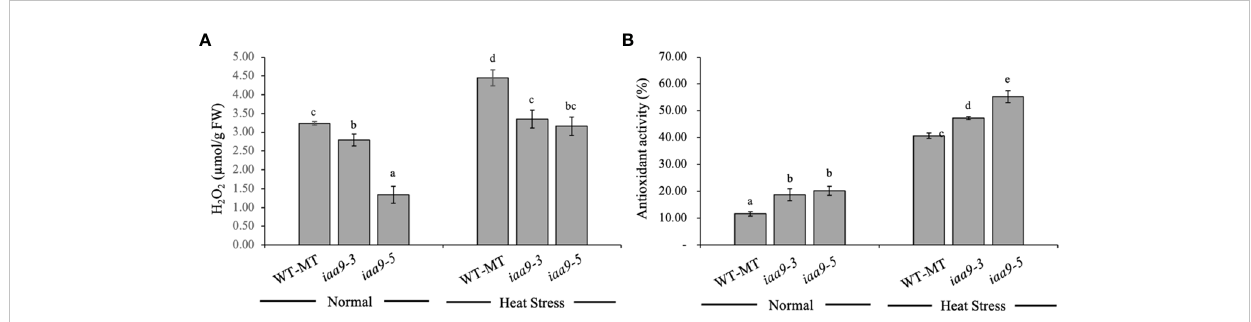
FIGURE 7 (A) H (B) Antioxidant activity of WT-MT, iaa9-3 , and iaa9-5 leaves under two temperature conditions, normal temperature, and heat stress 2 O 2 and conditions. The average value ± standard error (SE) (n = 4) followed by the same lowercase letters is not signi fi cantly different based on Duncan ’ s Multiple Range Test at